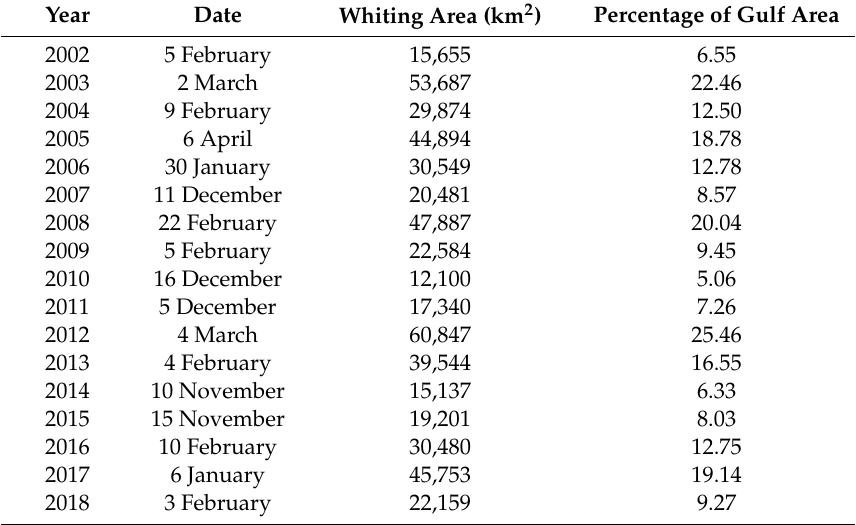
Table 6. Cloud-free MODIS images that show peak whiting patches between 2002 and 2018 and the computed whiting area